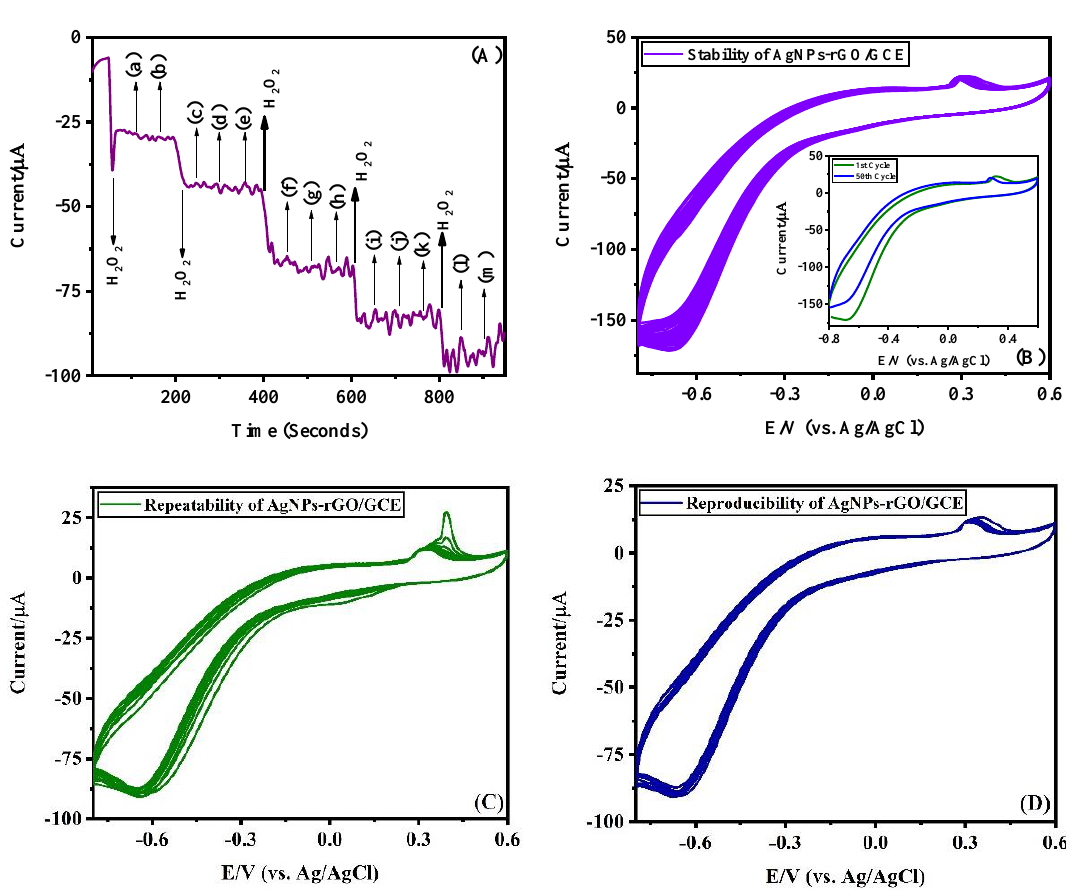
Figure 8. ( A ) Anti-interference ability of rGO-AgNPs/GCE in the presence of 50-fold excess of (a) Na + , (b) K + , (c) NH 4+ , (d) Mg 2+ , (e) Cl − , (f) SO 42− , (g) glucose, (h) urea, (i) nitrite, (j) serotonin, (k) tyrosine, (l) dopamine and (m) uric acid is recorded by the chronoamperometric method in 0.1 M PBS (pH 7.0). ( B ) Cyclic voltammograms recorded for 50 cycles at rGO-AgNPs/GCE in 800 µM of H 2 O 2 in 0.1 M PBS (pH 7.0) at a scan rate of 50 mV/s and inset shows the CVs of first cycle and 50th recorded at AgNPs modified GCE. ( C ) Repeatability study was performed by making ten repetitive CV measurements at rGO-AgNPs/GCE in 700 µM of H 2 O 2 in 0.1 M PBS (pH 7.0) at a scan rate of 50 mV/s. ( D ) CVs performed for reproducibility of 10 different GCEs modified with rGO-AgNPs in 700 µM H 2 O 2 in 0.1 M PBS (pH 7.0) at a scan rate of 50 mV/s.